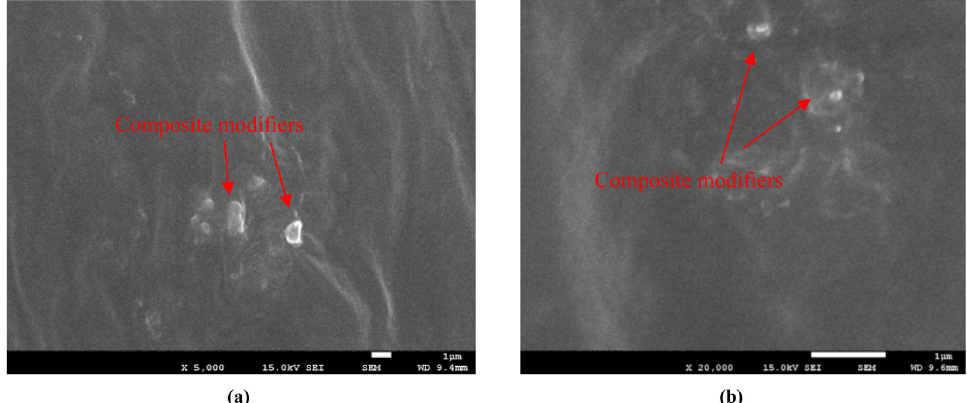
Figure 8: Di ff erent magni fi cation images of composite - modi fi ed asphalt: ( a ) composite - modi fi ed asphalt ampli fi es 5,000 times and ( b ) composite - modi fi ed asphalt ampli fi es 20,000